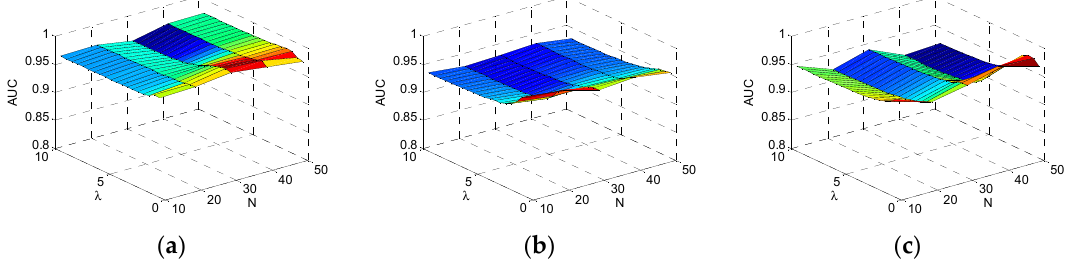
Figure 6. The AUC surfaces of the detection results of LRRaLD with different parameters ( λ and N ) under complex background: ( a ) F1; ( b ) F2; and ( c ) V1.